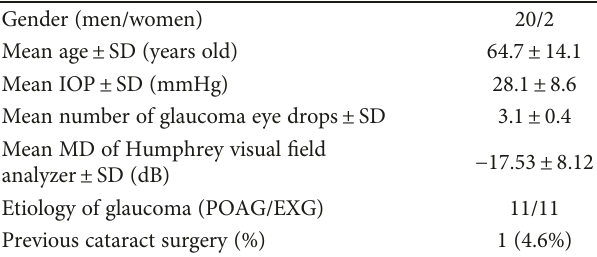
Figure 2: Flowchart showing patient inclusion. One patient of “ lost to follow-up ” could not come at a given moment, because the patient was admitted to a hospital for a general disease. Two patients of “ protocol deviations ” presented unanalyzable OCT imaging slices due to involuntary eye movement during the follow-up period. Table 1: Demographic characteristics